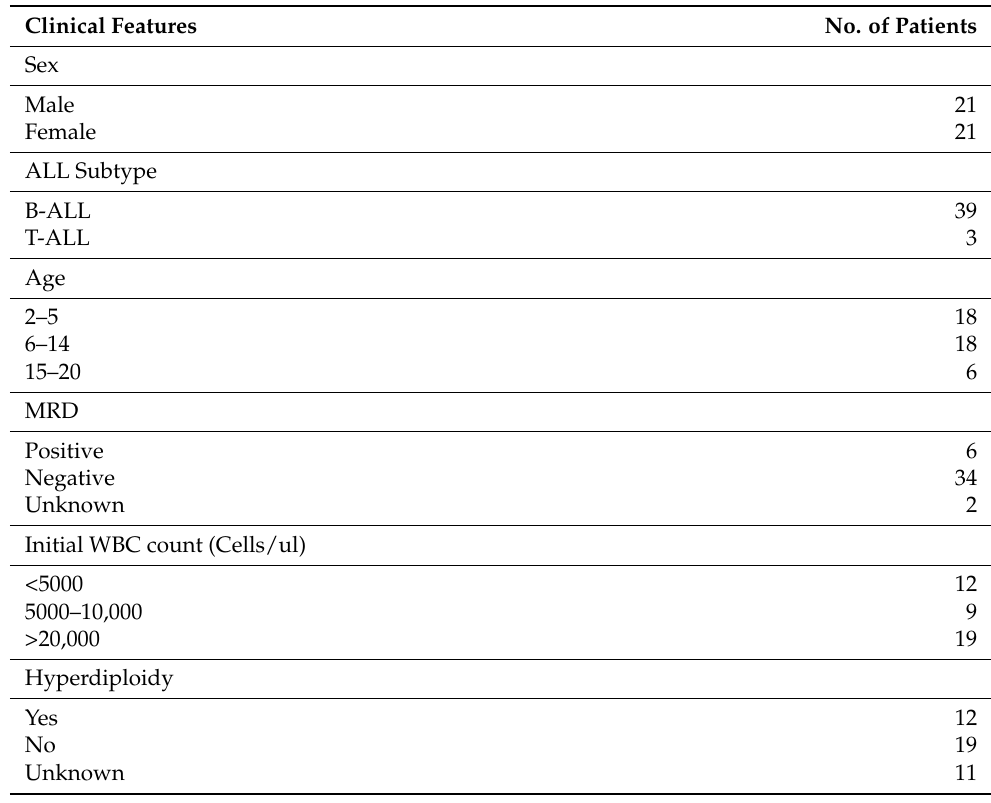
Table 1. Demographic and clinicopathological features of ALL